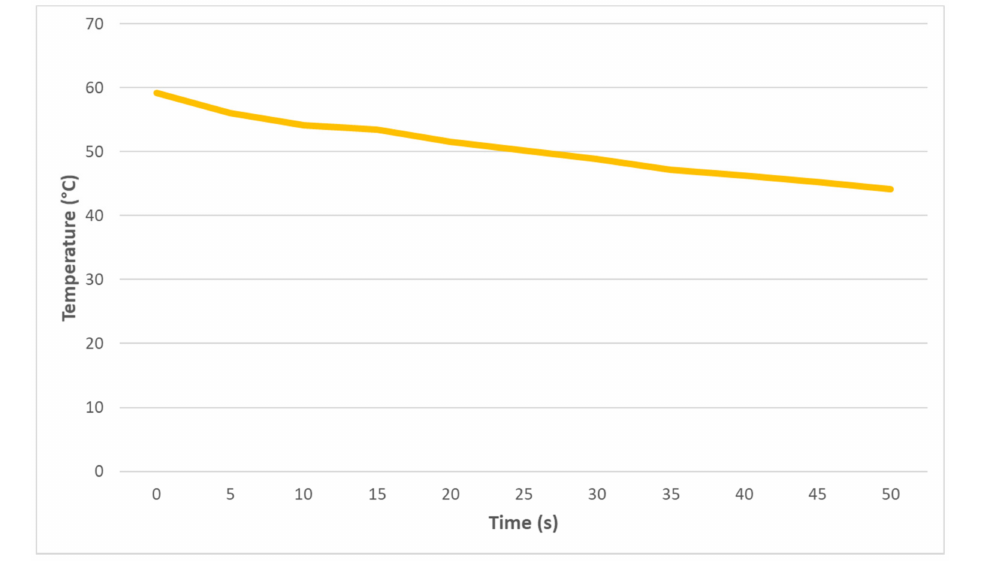
Figure 9. Temperature measurement for the inspected surface during the cooling